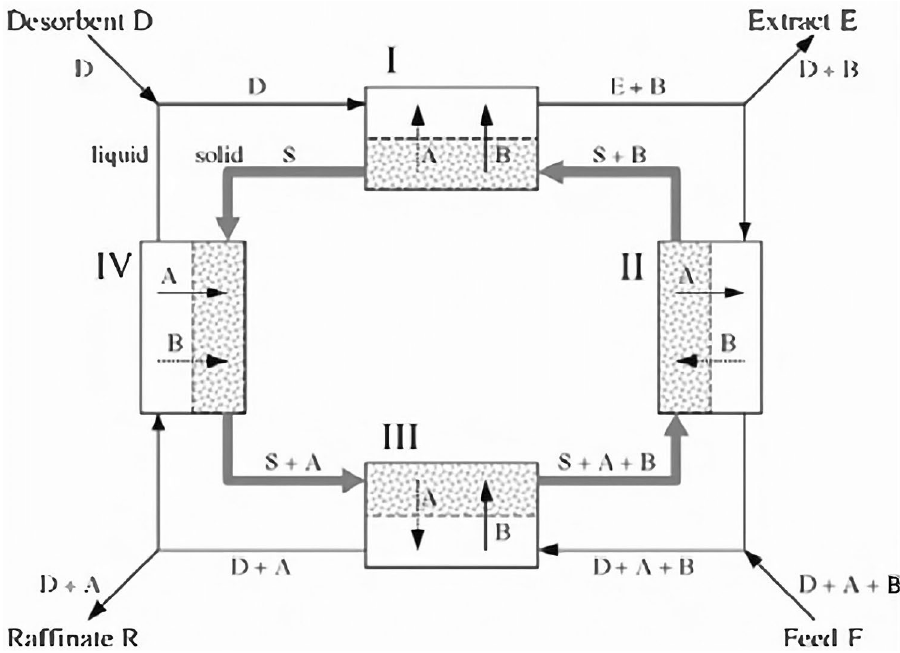
Figure 1. Simulated moving bed operation